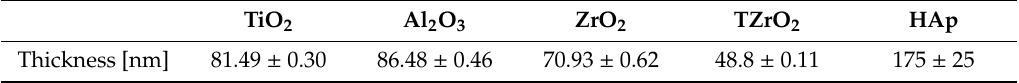
Table 3. Thickness of one-component oxide and hydroxyapatite (HAp) coatings.